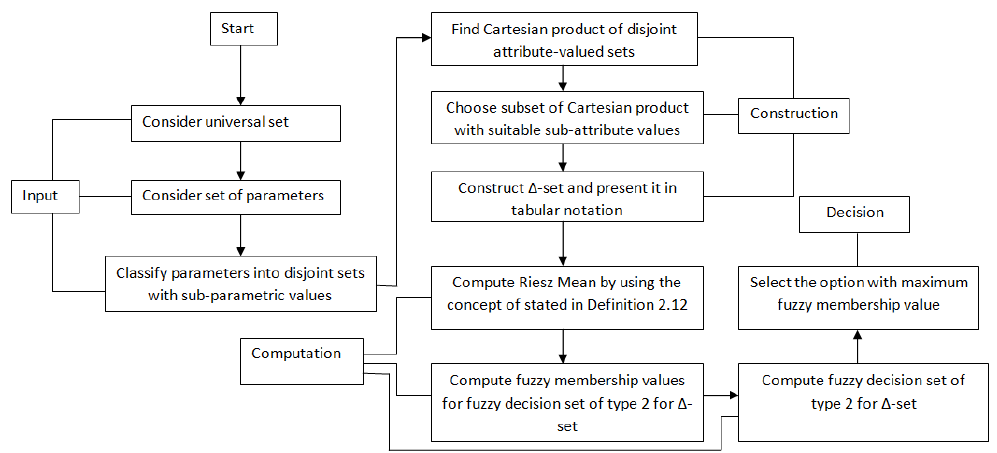
Figure 9. Algorithm Based on Decision Set of